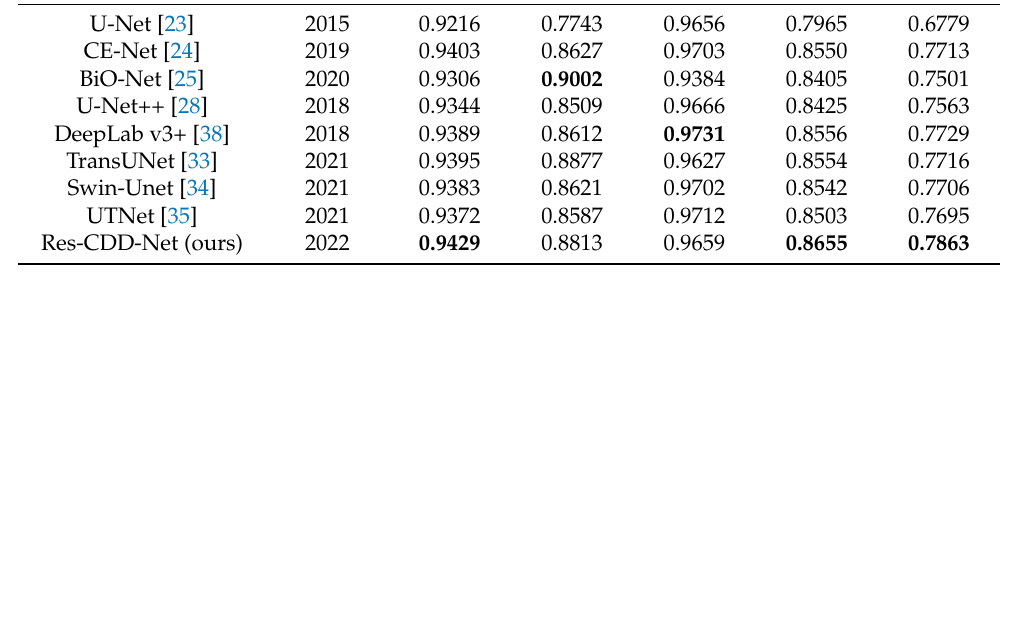
Table 3. Testing results of our Res-CDD-Net and other mainstream networks on the ISIC-2017 dataset.